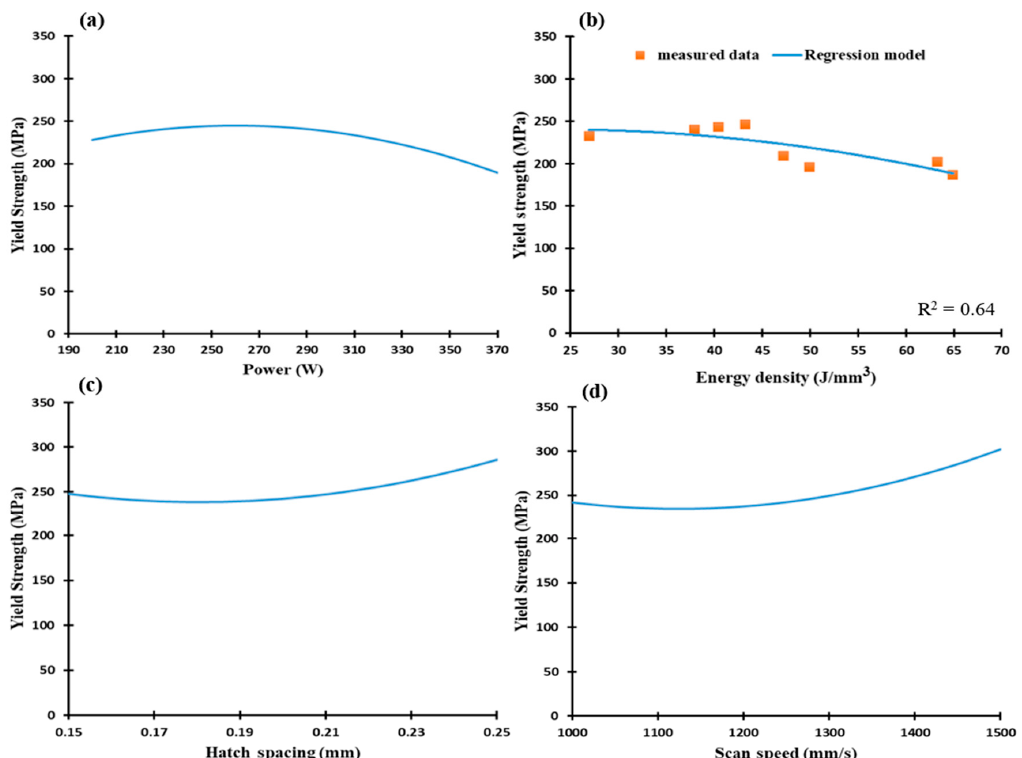
Figure 15. Yield strength of the as-built AlSi10Mg samples vs. ( a ) Laser power (W); ( b ) Energy density (J/mm 3 ); ( c ) Hatch Spacing (mm), and ( d ) Scan speed (mm/s).